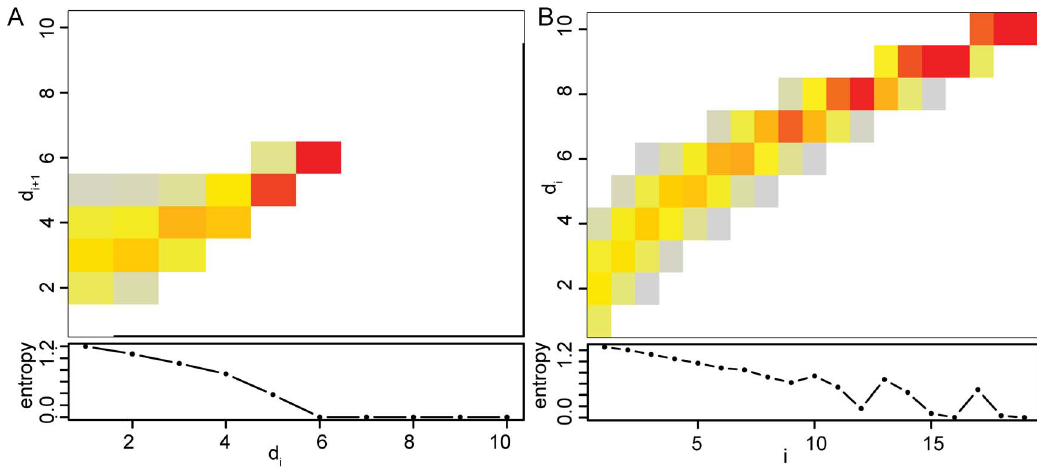
p c log p c ( bottom ). The probability d i z 1 ~ 1